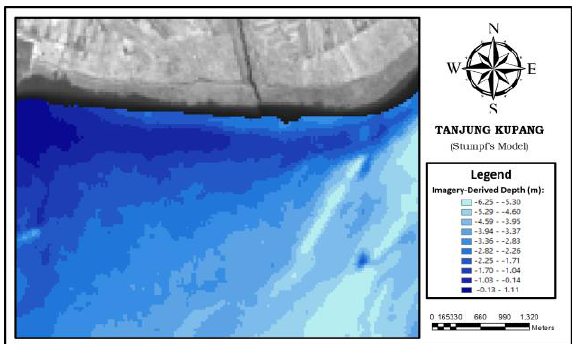
Figure 4. Imagery-derived bathymetric model from Stumpf’s approach over the study area.